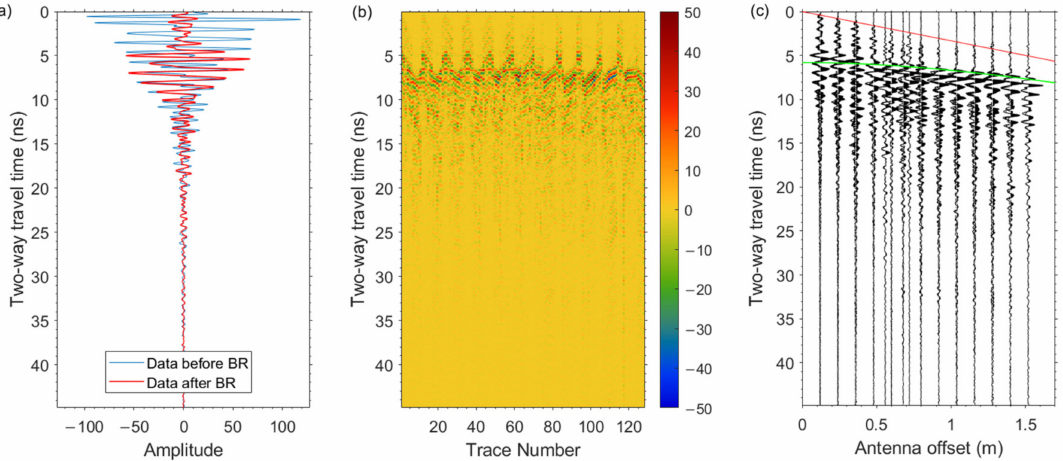
Figure 4. ( a ) Comparison of a single trace before and after background removal (BR). ( b ) Radargram of the observation data after processing. ( c ) Wiggle form of the observation data after processing. The red and green lines indicate the theoretical arriving time of direct waves and ground-reflected